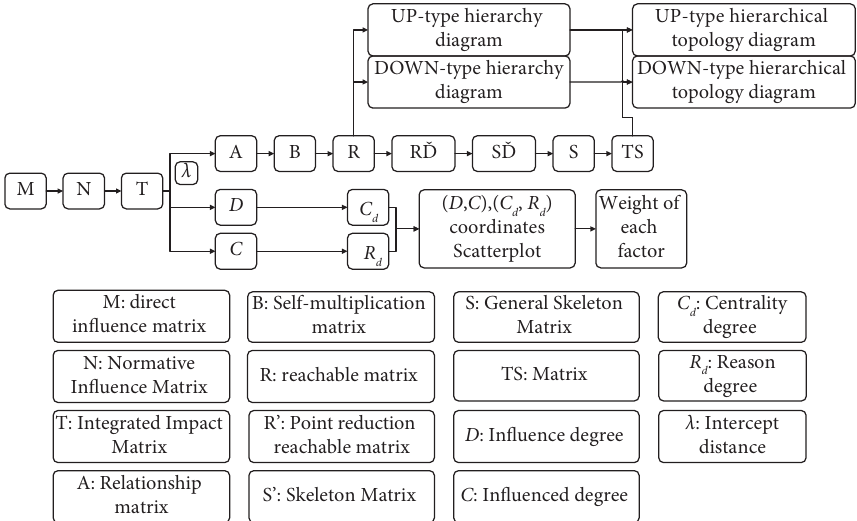
Figure 2: DEMATEL-AISM calculation fow